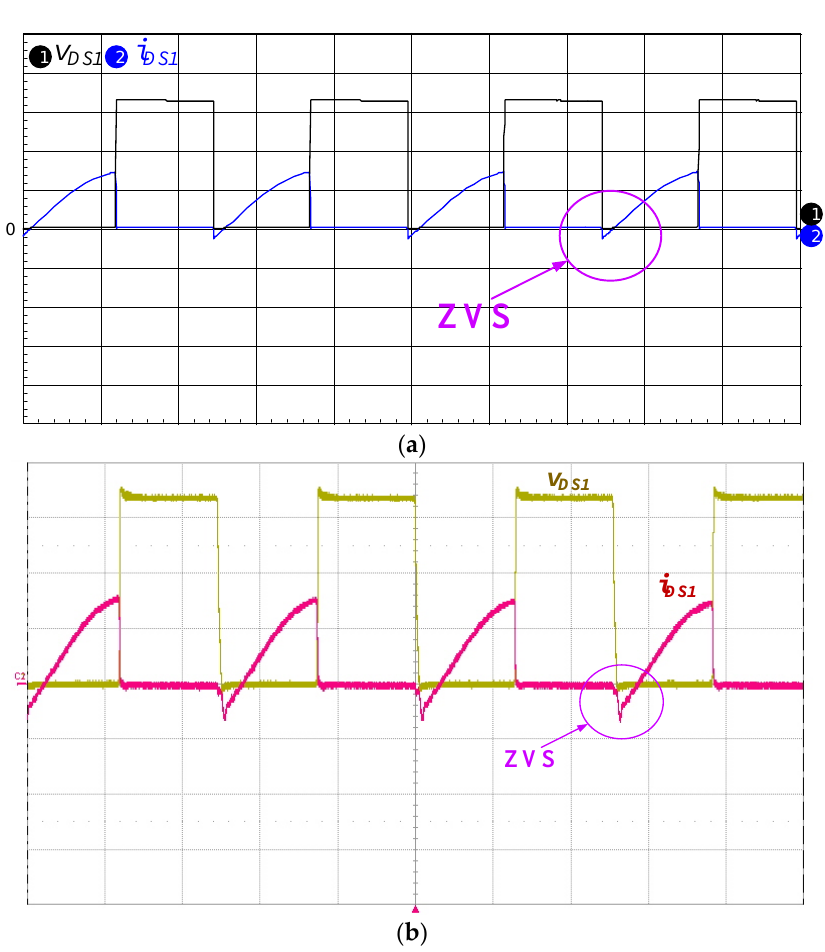
Figure 18. ( a ) Simulated and ( b ) measured switch voltage v DS1 (200 V/div) and switch current i DS1 (2 A/div); time scale: 10 μs/div .